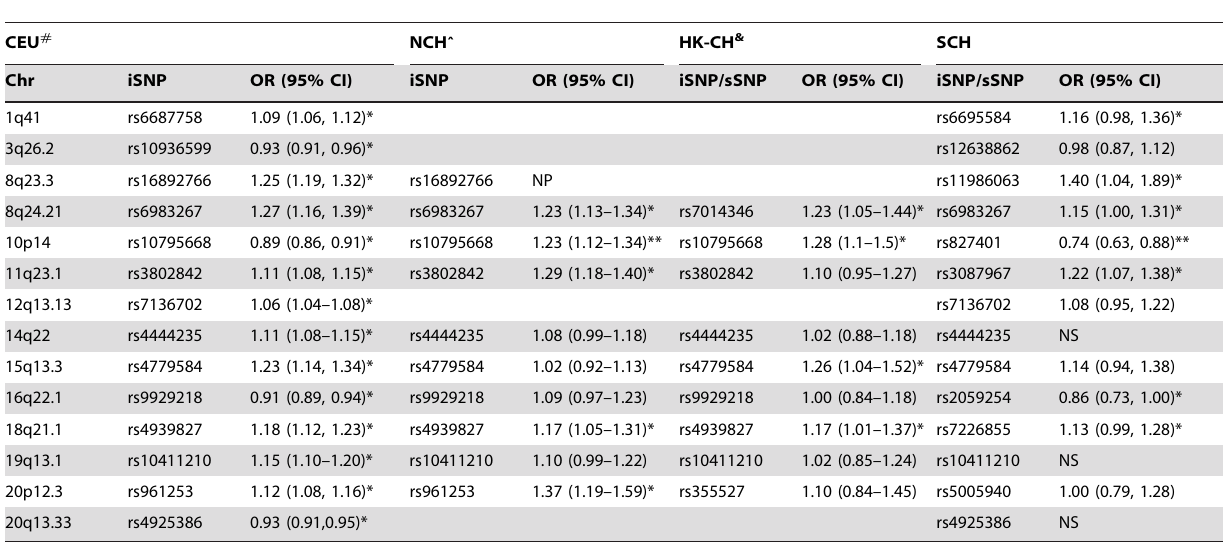
Table 3. Comparison of effect sizes of CEU-identified variants for CRC across CEU and three different Chinese